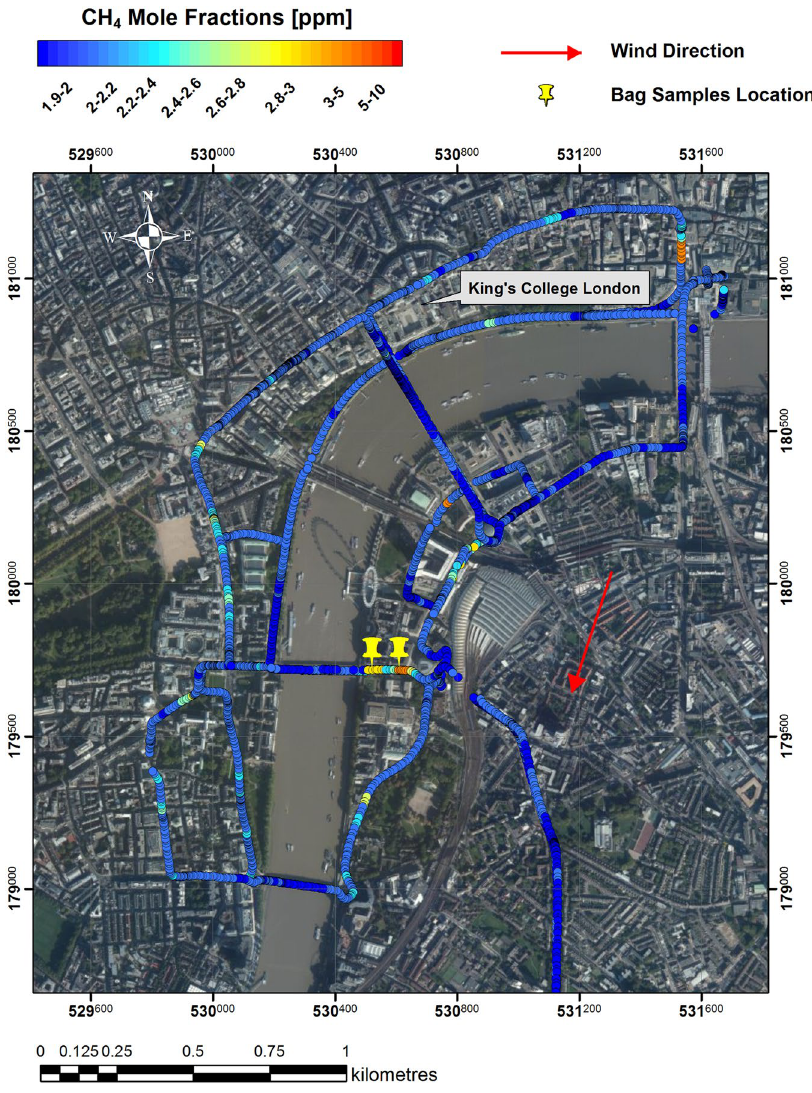
Figure 6. Methane mole fractions (ppm) measured in central London on 20 th March 2015 between 8 and 9 a.m. The map was generated using ArcMap 10.2. Base map source: Esri, DigitalGlobe, GeoEye, i-cubed, Earthstar Geographics, CNES/Airbus DS, USDA, USGS, AEX, Getmapping, Aerogrid, IGN, IGP, swisstopo, and the GIS User Community. British National Coordinate System